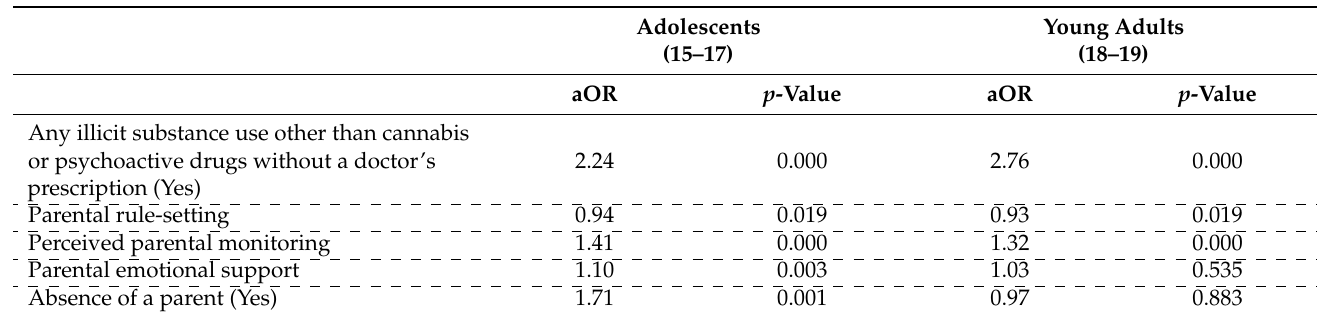
Table 7. Binary logistic regression models between any psychoactive substance use other than cannabis, parenting indicators, and violent behaviour in the past 12 months among adolescents and young